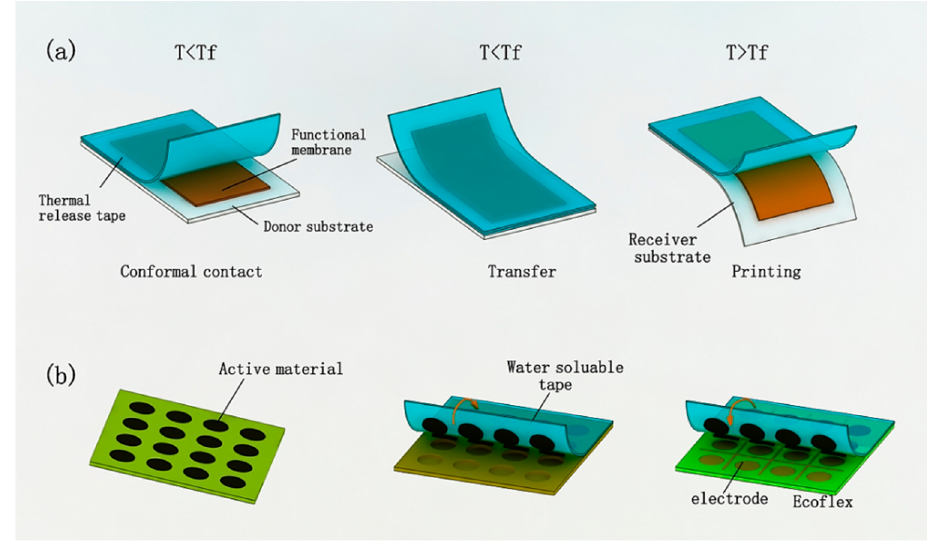
Figure 11. Tape-assisted transfer: ( a ) heat-release tape transfer, ( b ) water-soluble tape transfer.